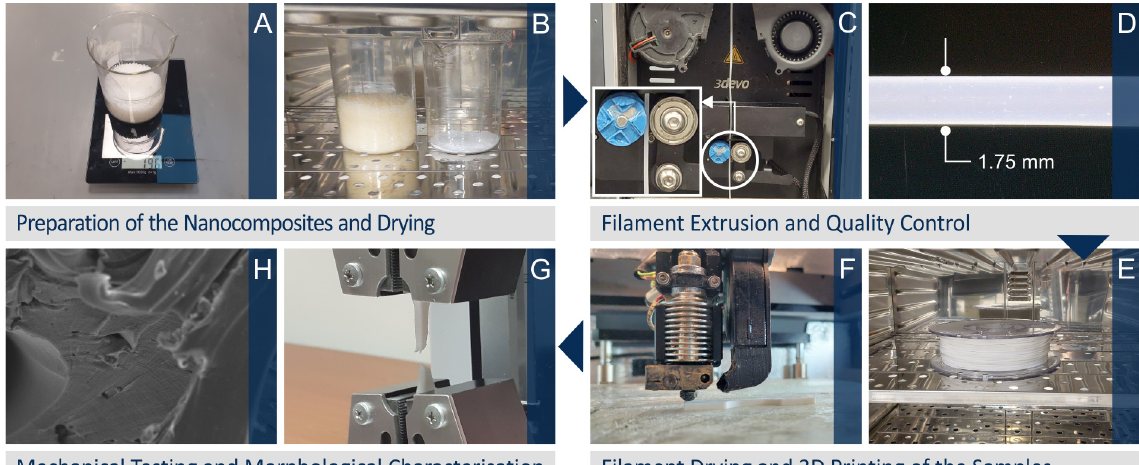
Figure 1. Steps of the methodology followed for the preparation of the 3DP filaments and the 3DP specimens towards the final testing and characterization ( A ) weight of the raw materials, ( B ) raw materials drying process, ( C ) filament extrusion, ( D ) filament inspection, ( E ) filament drying, ( F ) 3D printing of the samples, ( G ) mechanical characterization (a screenshot from a tensile test is shown in the picture), ( H ) morphological characterization with Scanning Electron Microscopy (SEM).